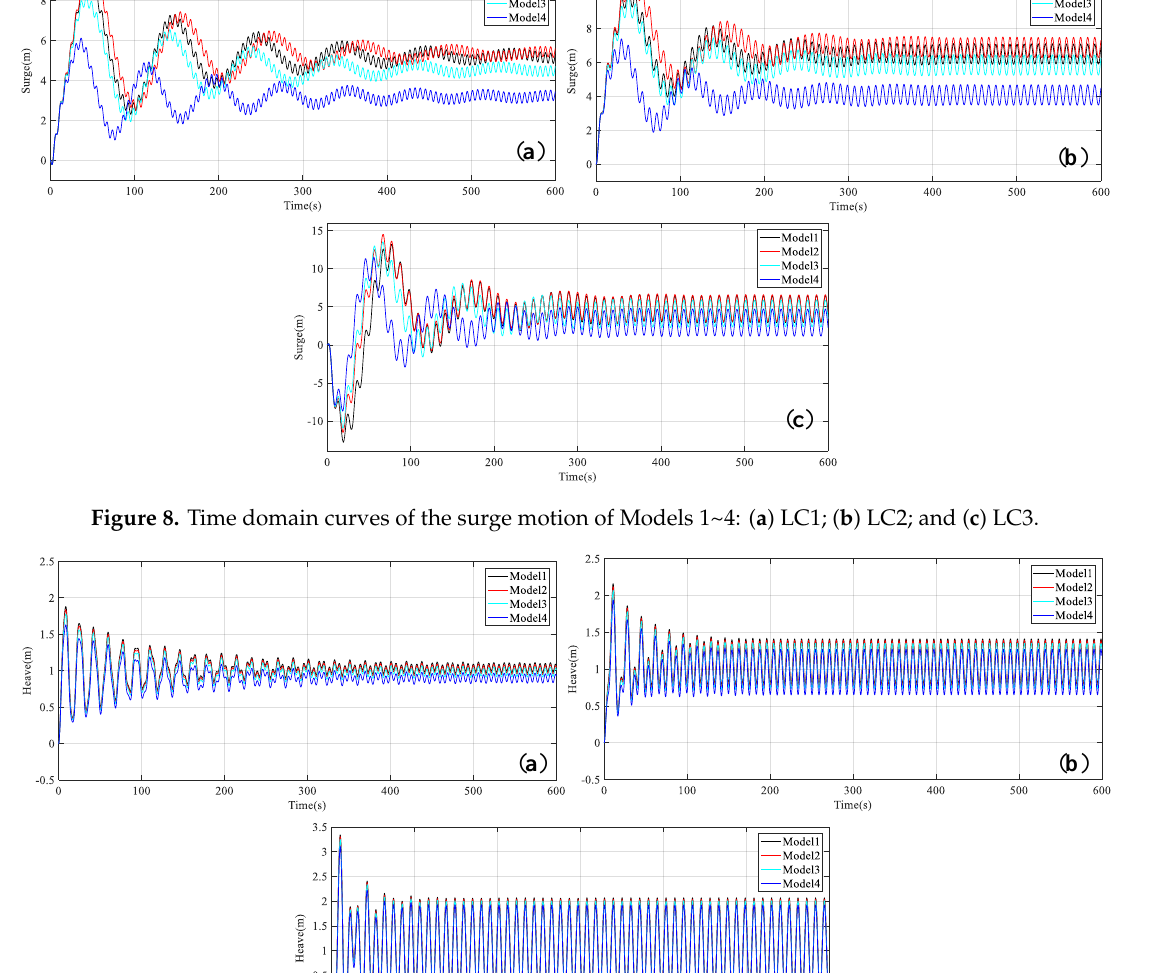
Figure 10. Time domain curves of the pitch motion of Model 1–4: ( a ) LC1; ( b ) LC2; and ( c ) LC3.